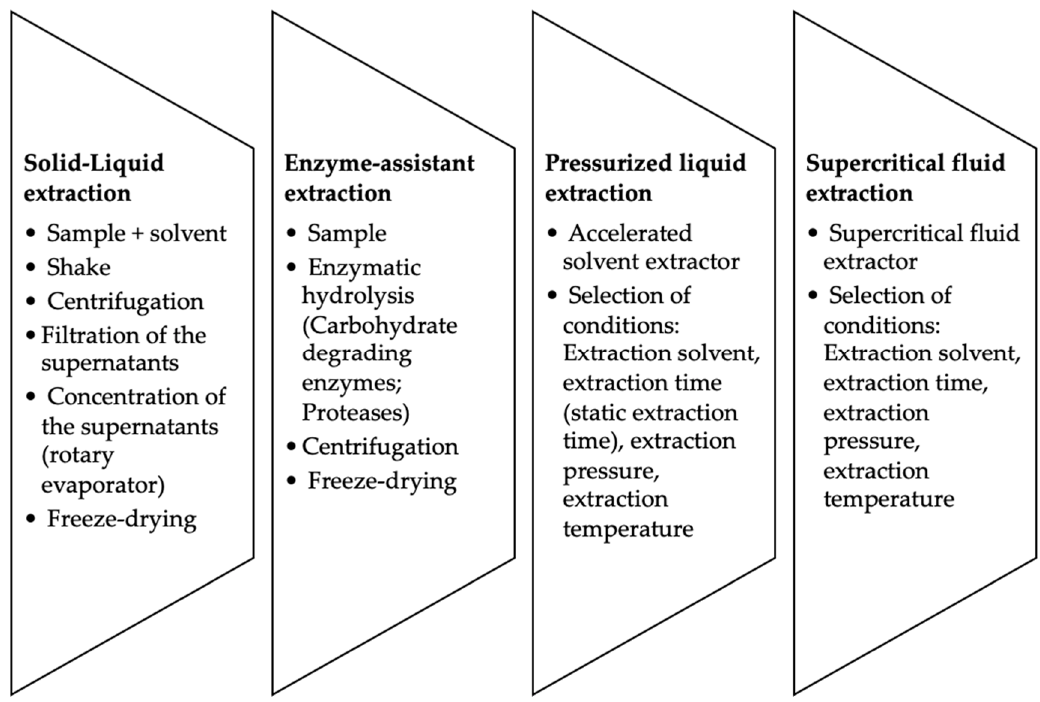
Figure 1. Scheme of protocols used for the extraction of bioactive compounds from seaweed. A conventional solid–liquid extraction and pressurized liquid extraction were com- pared to extract polyphenols from the seaweeds Ascophyllum nodosum , Pelvetia canaliculata , Fucus spiralis and Ulva intestinalis collected in Ireland. Different solvents including water, ethanol–water (80:20 v/v ), and acetone–water (80:20 v/v ) were assayed and the pressurized liquid extraction was carried out using an accelerated solvent extractor. The total polyphe- nol content was determined by using the Folin–Ciocalteu reagent, and the antioxidant activity was evaluated by radical scavenging ability, ferric reducing antioxidant power, and ferrous ion chelating capability assay. The mixture of acetone–water (80:20 v/v ) provided the best results for the total polyphenol content when pressurized liquid extraction was used. However, when solid–liquid extraction was applied, and for brown seaweeds, satis- factory results were obtained with water and ethanol–water (80:20 v/v ). With respect to the antioxidant activity, the assays performed with solid–liquid extraction using the mixture of water and ethanol gave better results when compared with those made by employing the pressurized liquid extraction procedure for both DPPH and FRAP assays. The authors concluded that the high temperatures and pressures employed in the pressurized liquid extraction do not produce extracts with high antioxidant activity [40].